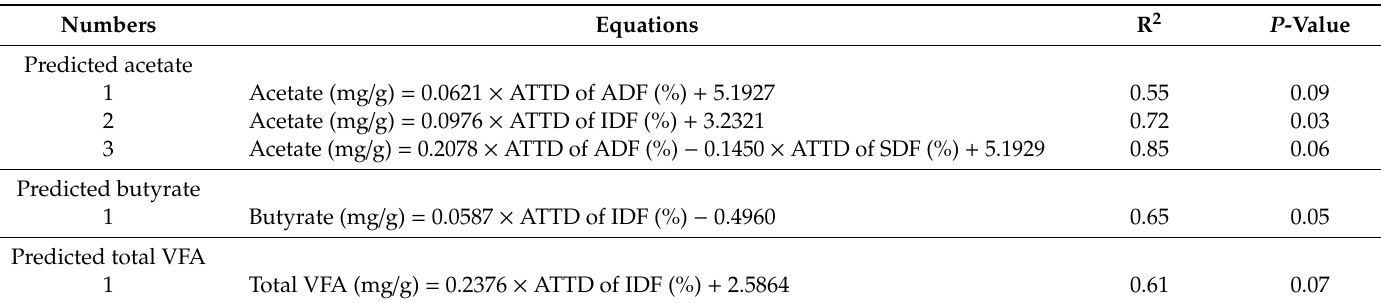
Table 8. The prediction equations for fecal VFA concentration by using the ATTDs of di ff erent dietary fiber components in pigs 1